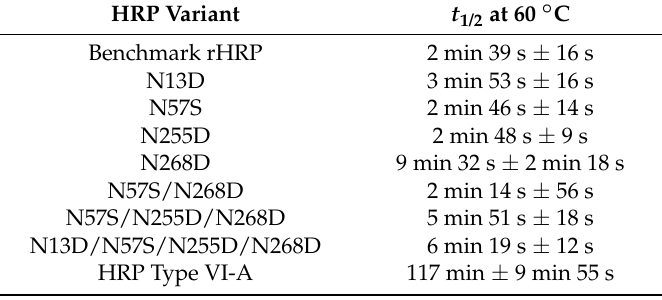
Table 3. Half-life of plant HRP, rHRP and seven rHRP variants at 60 ◦ C in 50 mM BisTris/HCl pH 7, 7% glycerol, 100 mM